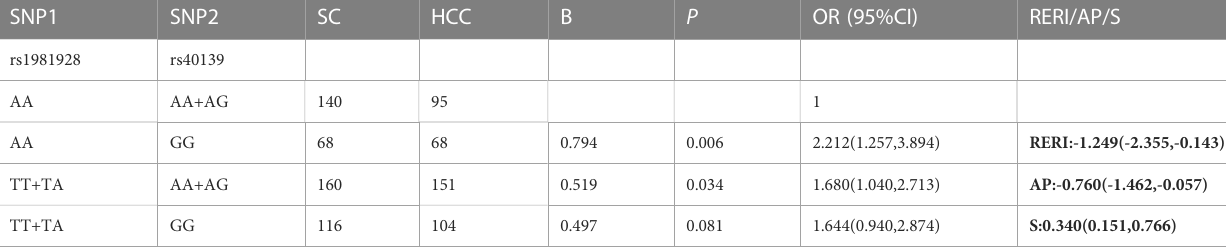
TABLE 6 The positive results of additive interaction analysis of SNPs and four other factors in SC vs. HCC group. SNP1